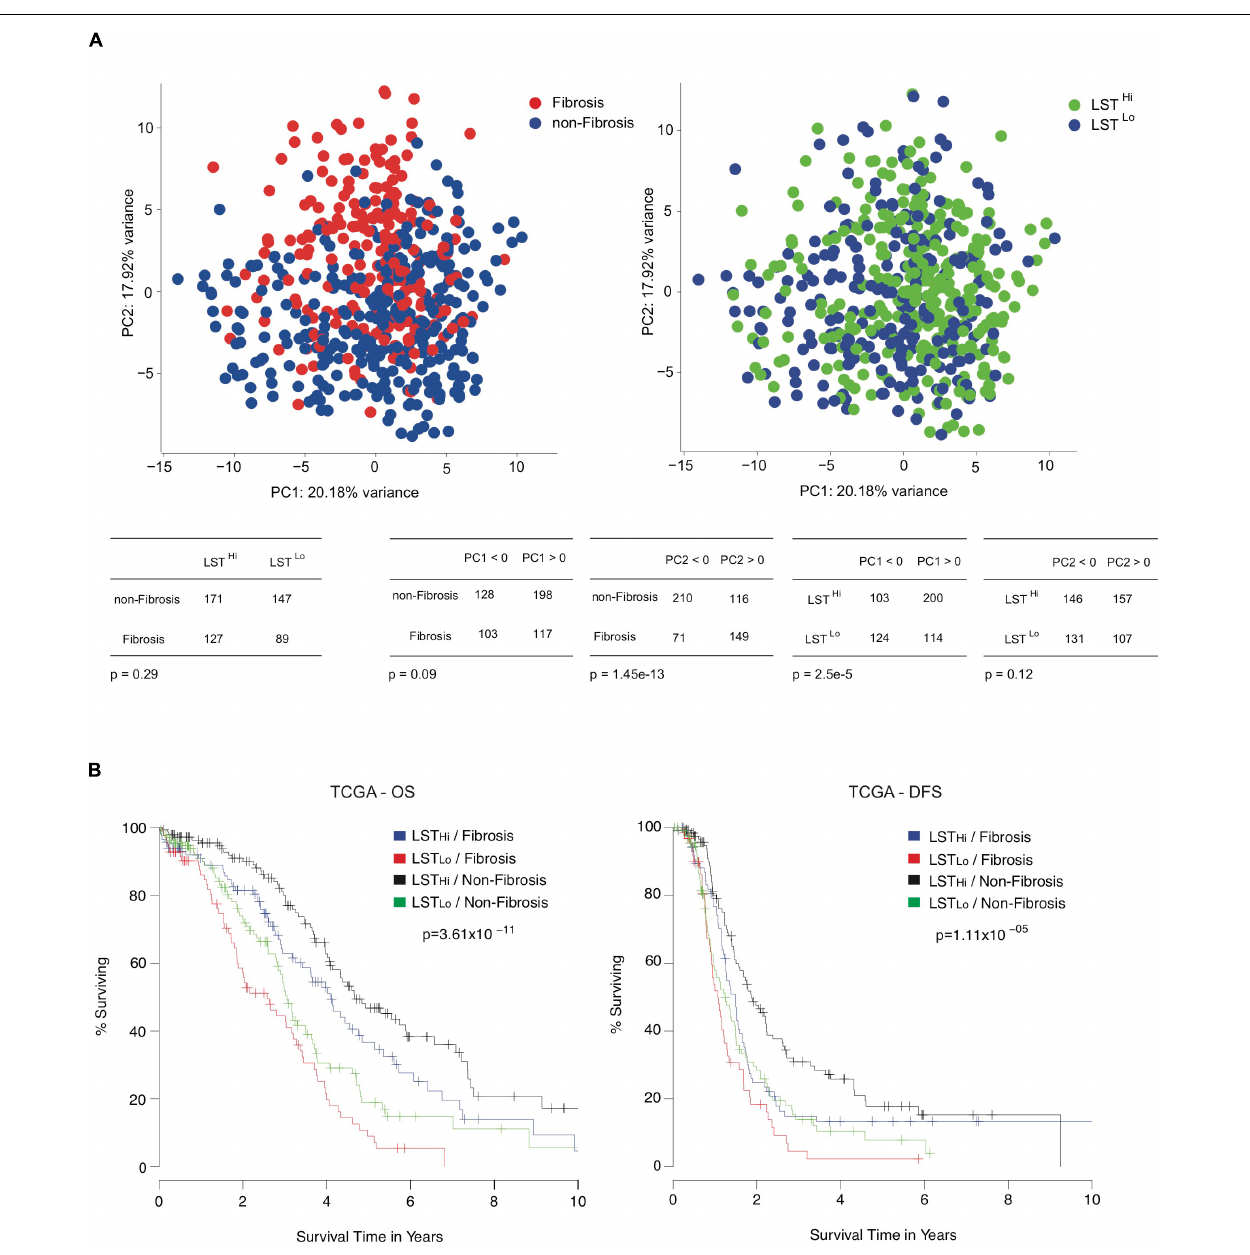
FIGURE 3 | Combining genomic and transcriptomic signatures provide additive prognostic values for high-grade serous ovarian cancer patients. ( A , Up) Principal component analyses (PCA) applied on transcriptomic data from the TCGA cohort using Verhaak’s signature. On the left panel, the color code shows the non-Fibrosis (blue, N = 326) and Fibrosis (red, N = 220) subgroups, using Mateescu’s signature (Mateescu et al., 2011). The right panel shows the same PCA representation but subgroups are highlighted using the LST genomic signature (Popova et al., 2012). The color code represents LST Lo (blue, N = 238) and LST Hi (green, N = 303) ovarian cancers. (Down) Contingency tables showing the repartition of patients regarding Mateescu or LST classification and the repartition against the two first principal components. (B) Kaplan-Meier curves showing 10-year overall survival (OS, Left) and disease-free survival (DFS, Right), after stratification into four groups: LST Lo /Fibrosis (red, N = 89), LST Lo /non-Fibrosis (green, N = 147), LST Hi /Fibrosis (blue, N = 127), and LST Hi /non-Fibrosis (black, N = 171). P -values are calculated using the Log-rank